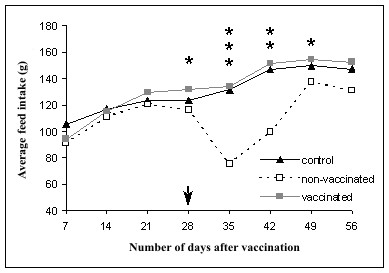
Vaccination experiment followed by challenge with a homologous strain after 28 days. Average feed intake of the different groups of rabbits plotted against day after vaccination. Vaccination with strain 97/246.1Δeae was performed immediately after weaning. Both the vaccinated and non-vaccinated groups were challenged at day 28 after vaccination (arrow) with strain 97/223.10. Significant differences between the non-vaccinated and the other groups are indicated with asterisks (***: P < 0.001; **:P < 0.01; *:P < 0.05).